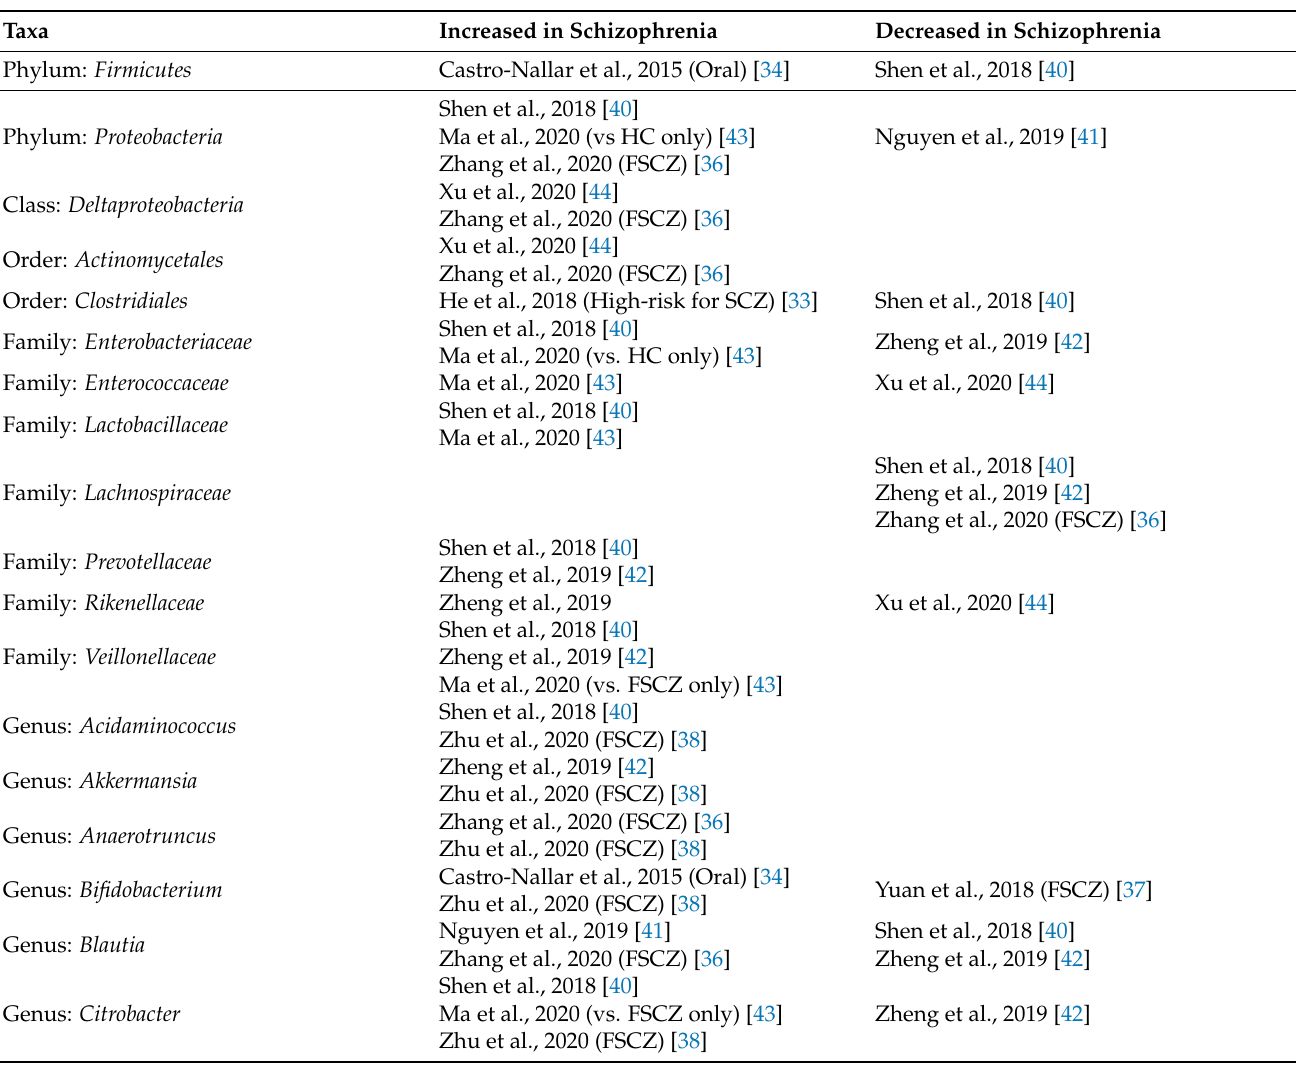
Table 2. List of taxonomic groups that were significantly increased/decreased in multiple studies. Increased in Schizophrenia Decreased in